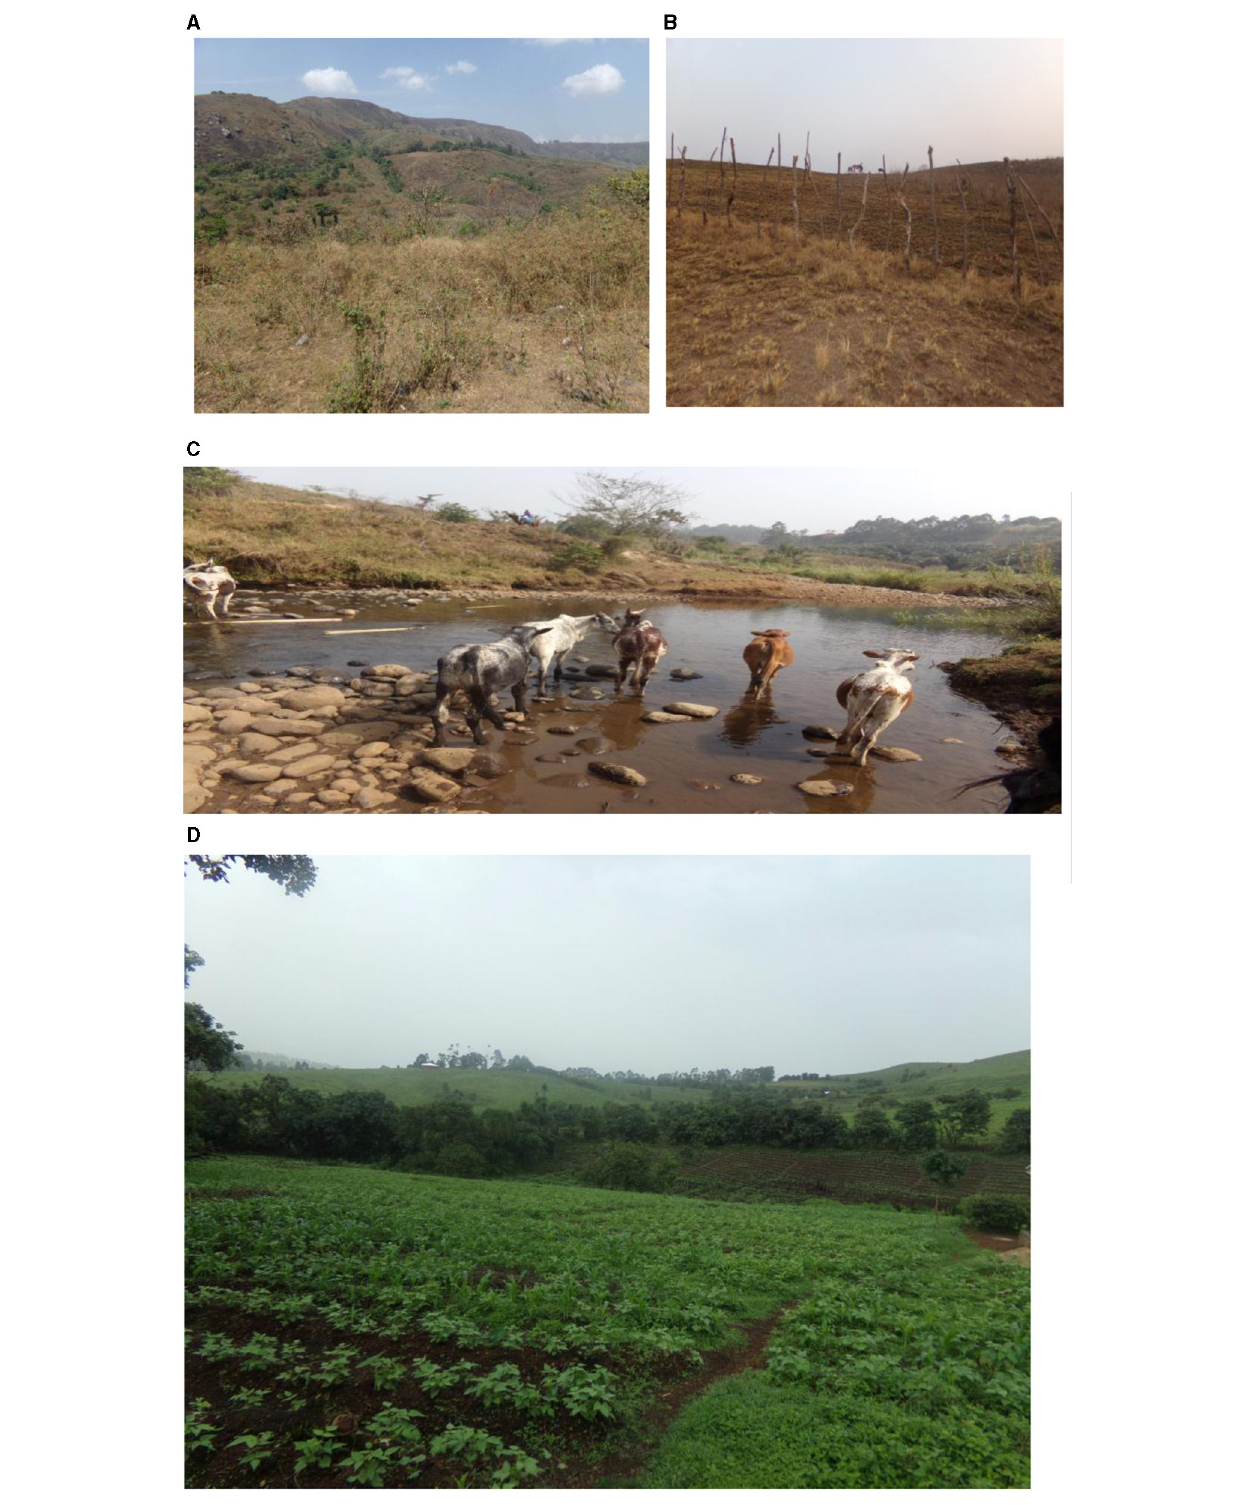
FIGURE 6 | (A,B) Pasture and rangeland degradation. (C) Shrinking river course. (D) Encroaching of crop farming into grazing lands. Source: Umaru (2018).